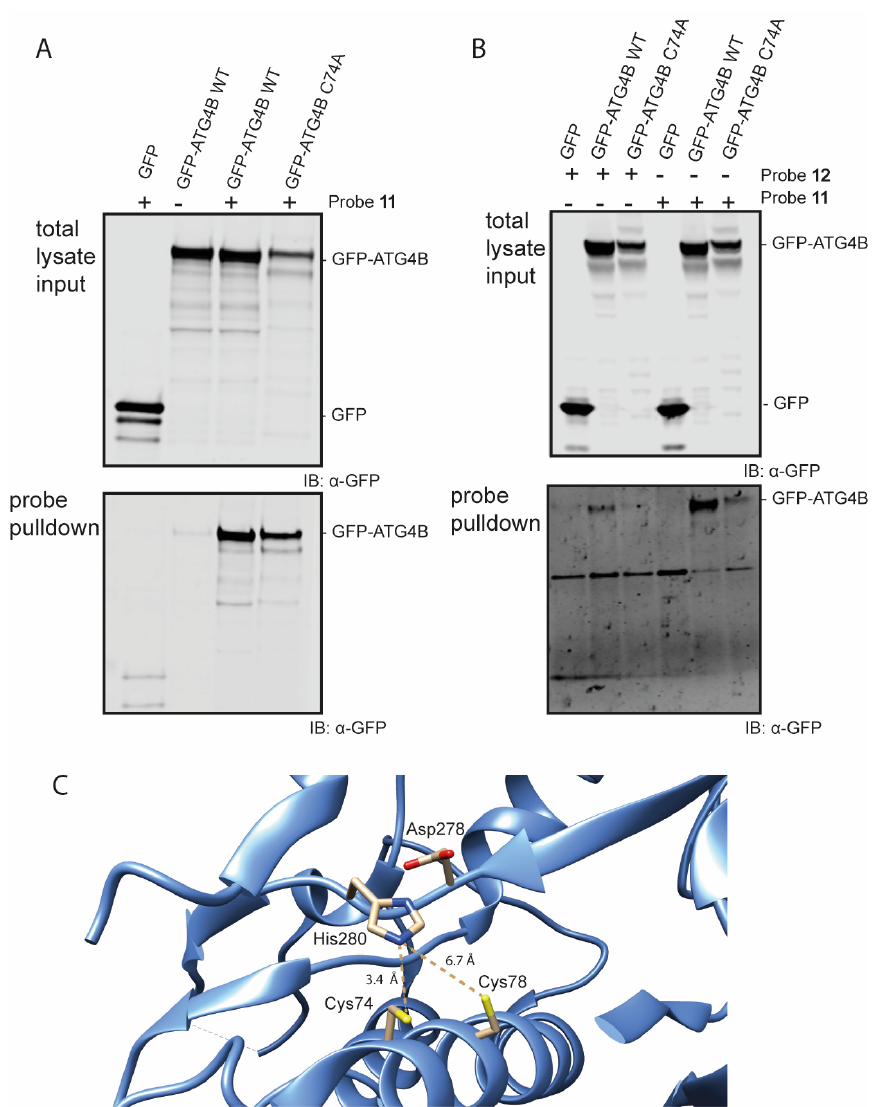
Figure 4. Western blot analysis of the pull-down of GFP-Atg4B and GFP-Atg4B C74A from cell lysate ( A ) using probe 11 and mild washing conditions. ( B ) using probes 11 and 12 using harsh washing conditions. ( C ) Crystal structure of the active site of Atg4B (PDB: 2CY7). Cys74 has a distance of 3.4 Å to the His280 residue and Cys78 has a distance of 6.7 Å to the His280